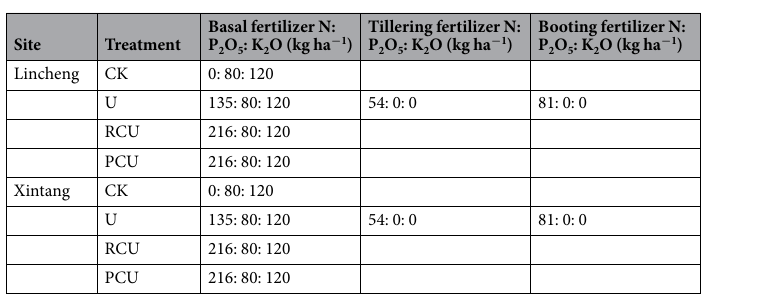
Table 1. Application rate and timing of fertilizers for the four treatments at the two experimental sites during the 2015 to 2017 rice growing seasons. CK, U, RCU and PCU represent no N application, conventional urea, resin-coated urea and polyurethane-coated urea, respectively.